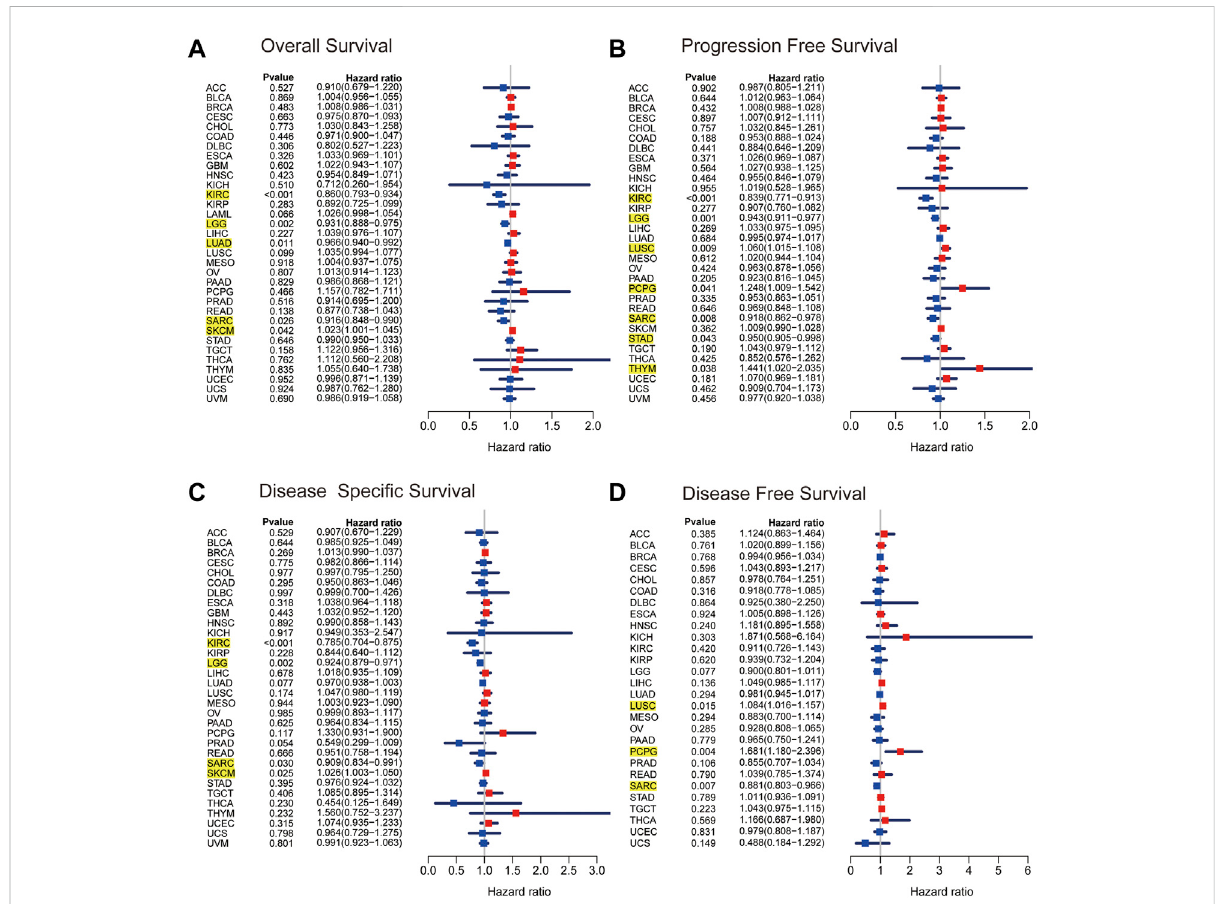
FIGURE 3 The Kaplan – Meier plots ofunivariateCox regressionanalyses. Forest plots showing theassociations between ARRB1 expression and (A) OS, (B) PFS, (C) DSS,and (D) DFSofpatientsin33cancers.Theyellowhighlightedsectionsuggested thatARRB1 expressionwassigni fi cantlyassociatedwith prognosis in these cancers ( p <